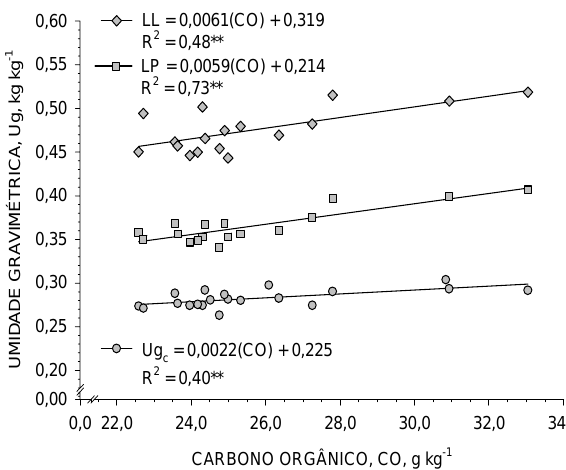
CARBONO ORGÂNICO, CO, g kg -1